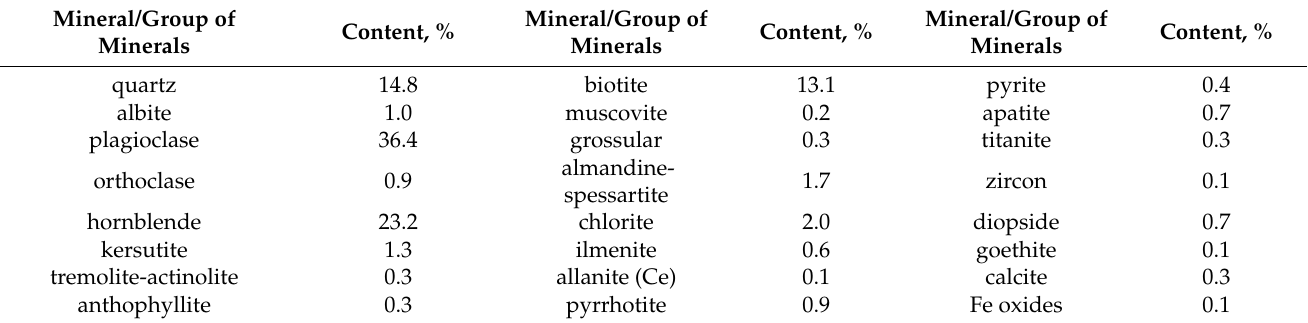
Table 3. Mineral composition of studied waste sample from Pilawa Gorna.